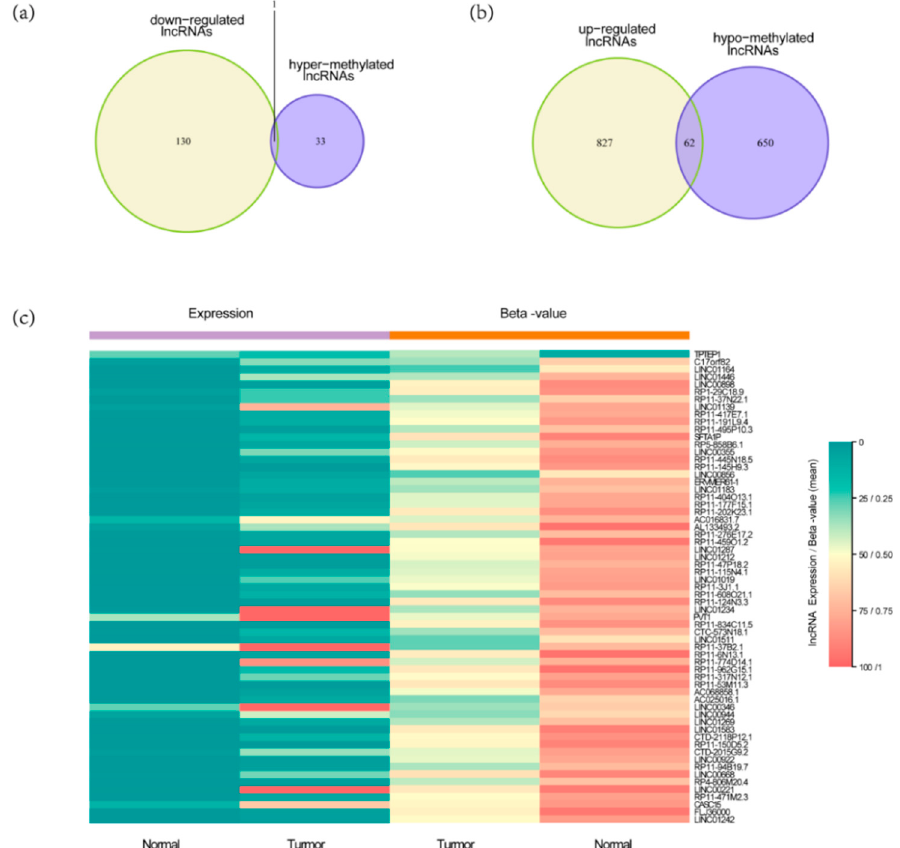
Figure 3. The process of screening candidate lncRNAs and their expression profiling in HCC tissues and normal tissues. ( a ) Downregulated lncRNAs with hypermethylation status ( n = 1); ( b ) Upregulated lncRNAs with hypomethylation status ( n = 62); ( c ) 63 lncRNAs expression and methylation cluster analysis.